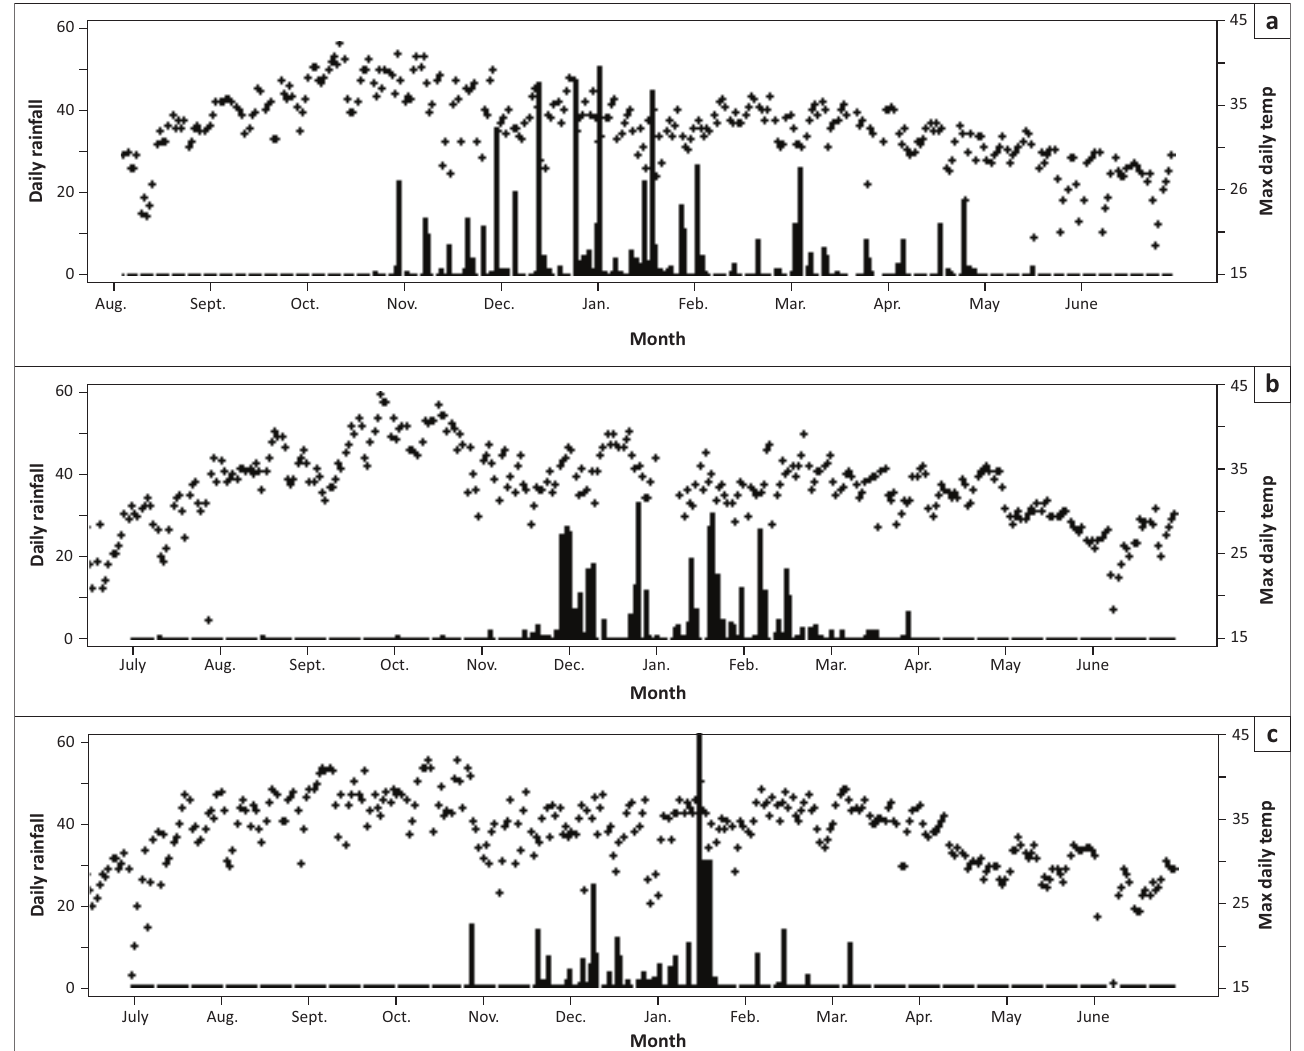
FIGURE 2: Rainfall and temperature patterns between 2010 and 2013. (a) 2010/2011, (b) 2011/2012 and (c) 2012/2013 rainfall season.